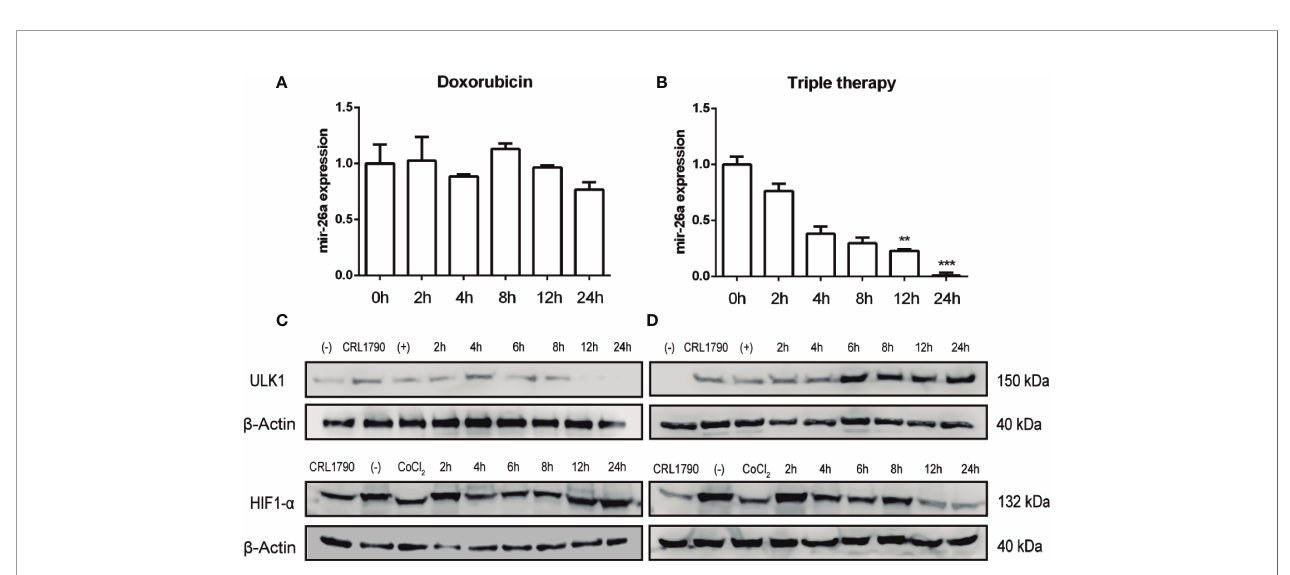
FIGURE 4 | Triple therapy decreases mir-26a expression. (A, B) Expression of mir-26a levels in HCT116 cells treated with doxorubicin and triple therapy, respectively. (C, D) Protein levels of ULK1 and HIF-1 a detected by western blot, b -actin was used as loading control. **P < 0.01, ***P <